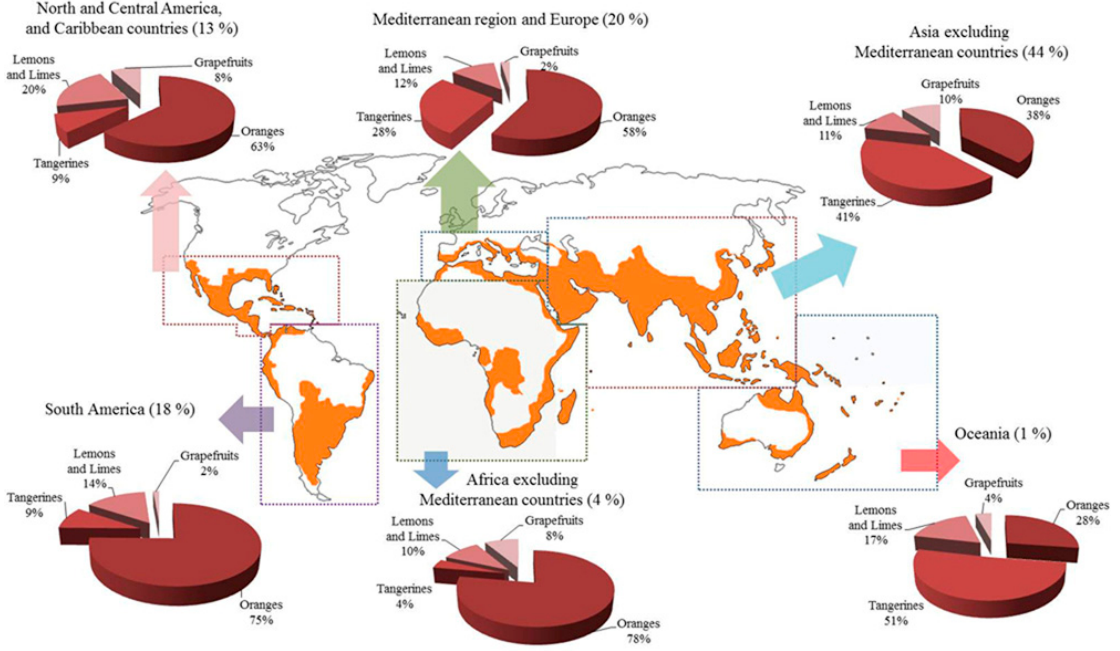
Figure 1. Climate sustainability and the annual production of citrus fruits in different geographical regions across the globe [3,4,15] .